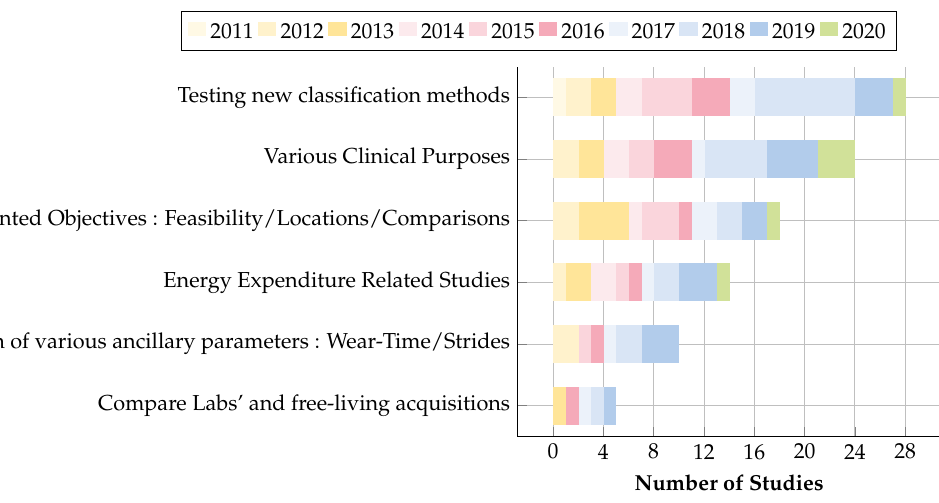
Figure 2. Change of the distribution of studies according to their aims over